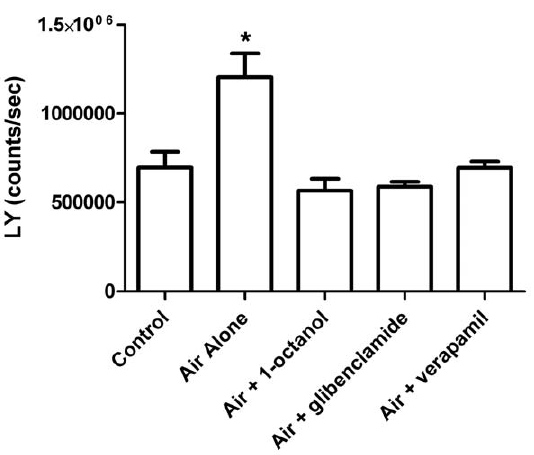
Figure 4. Assessment of connexin hemichannel involvement in air-stimulated ATP release. Uptake of the connexin permeable dye lucifer yellow (LY) was measured to confirm that connexin hemi- channels open in response to air exposure and are blocked by the same drugs that prevent ATP release. Cells were pre-incubated with ATP release inhibitors using the same procedure as for the pharmacological analysis assays. LY (500 m M final concentration) was added in the media after air exposure or a change of half the media (control). Sixty minutes later, cultures were rinsed twice with media containing 1-octanol (2 mM) to remove residual LY, but minimize leakage of absorbed LY. LY levels in the cell lysates were then measured. Air exposure significantly increased LY uptake compared to control and the same drugs that inhibited air-stimulated ATP release prevented this increase in LY uptake. This indicates that connexin hemichannels are open during air- stimulated ATP release. Values represent 8 or 9 wells per group + / 2 SEM, * p , 0.05 vs. control.